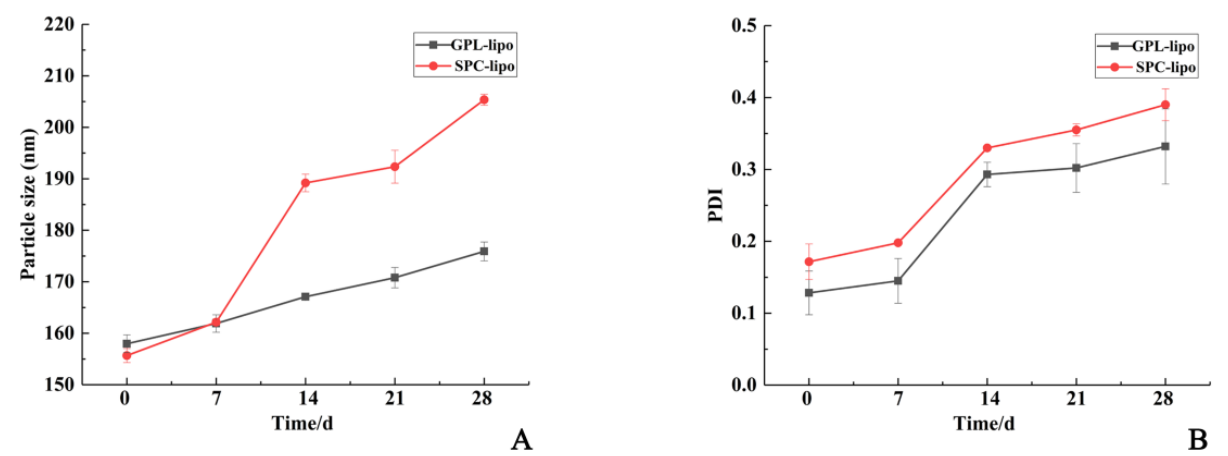
Figure 2. Comparison of storage stability of GPL-lipo and SPC-lipo. Comparative results of the change in encapsulation efficiency during storage for GPL-lipo and SPC-lipo are shown in the subfigures ( A ) and ( B ). The values reported are averaged over three measurements.